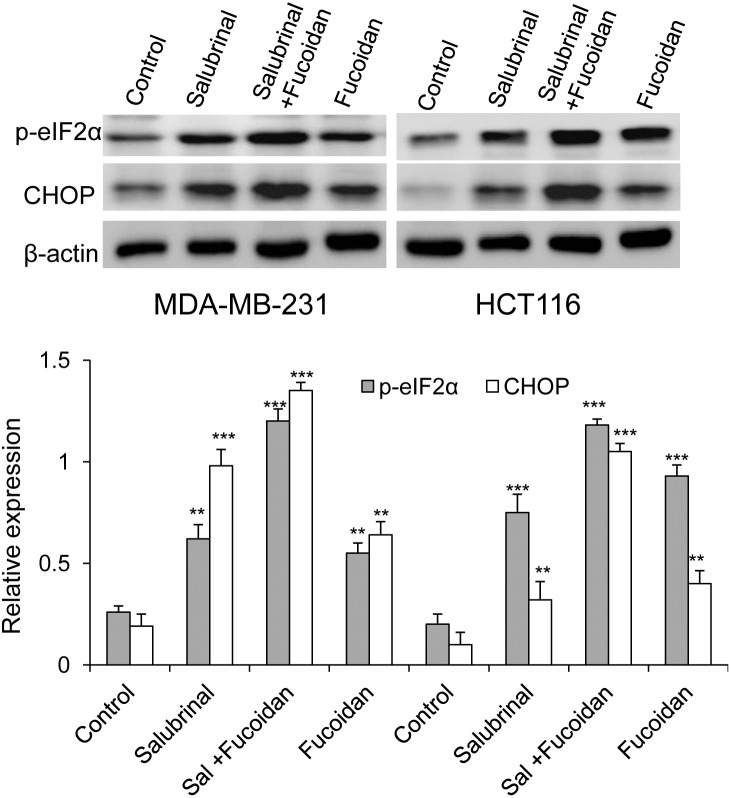
Combinatory treatment of fucoidan and salubrinal enhances eIF2α phosphorylation and CHOP expression in MDA-MB-231 cells and HCT116 cells.Cells were treated with salubrinal (50 µM) alone or in combination with fucoidan (100 µg/ml) for 48 h. Cell lysates (30 µg) were applied for the analysis of the expression of p-eIF2α and CHOP by immunoblot. **p<0.01; ***p<0.001.